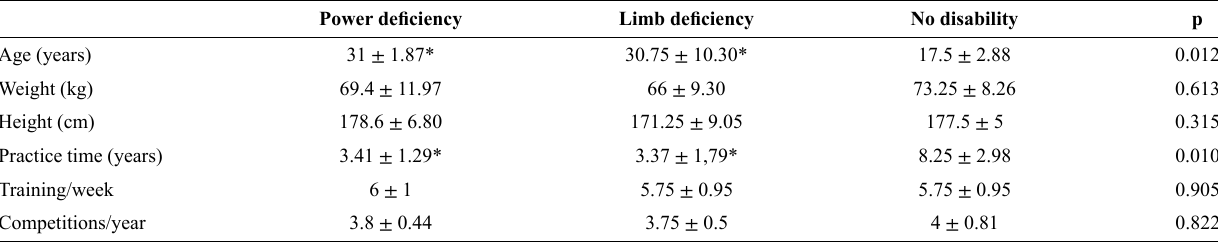
Table 1 - Characterization data for the evaluated